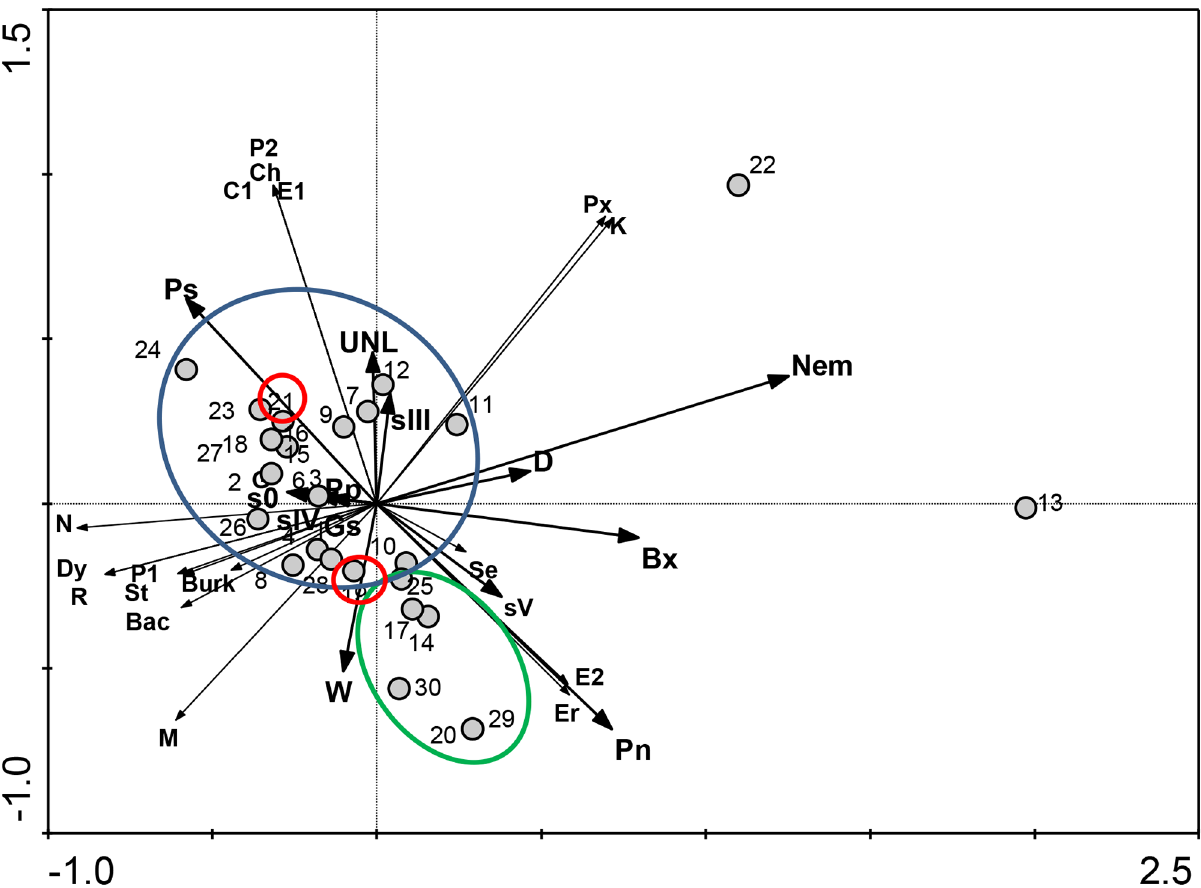
Figure 3. Relationships between pine trees species, bacterial communities and environmental variables. Redundancy analysis (RDA) performed with bacterial communities carried by PWN from five sampling sites. Circles highlight the closest relationship between P. sylvestris (blue), P. nigra (green) and P. ponderosa (red). The cumulative percentage of first and second axis explained 80.4% of variance. The genera included in this analysis are: Bac - Bacillus , Burk - Burkholderia , C1 - Comamonas , Ch - Chryseobacterium , Dy - Dyella , E1 - Enterobacter , E2 - Ewingella , Er - Erwinia , K - Klebsiella , M - Mangrovibacter , P1 - Pigmentiphaga , P2 - Pseudomonas , Px - Pseudoxanthomonas , R - Rhizobium , Se - Serratia , St - Staphylococcus . The environmental variables are: sampling areas (G, Gs, W, D, UNL), pine tree species (Pn – P. nigra, Pp – P. ponderosa , Ps – P. sylvestris ), presence of B. xylophilus (Bx) or other nematodes (Nem), and PWD symptom classes (s0, sIII, sIV, sV). The numbers are the pine trees sampled (Table 1).